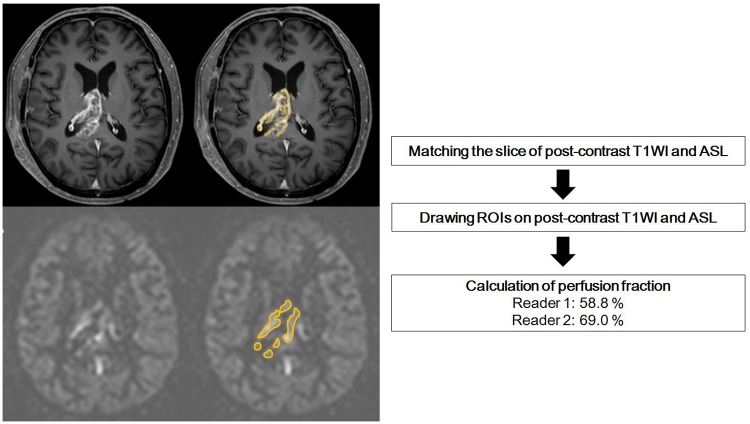
Accrual process for determining the perfusion status of surgical cavity wall enhancements.The perfusion fraction was calculated by dividing the area of the high perfusion on ASL MR imaging by the area of contrast-enhancement on postcontrast T1-weighted imaging. The perfusion fraction was 58.8% for reader 1 and 69% for reader 2.